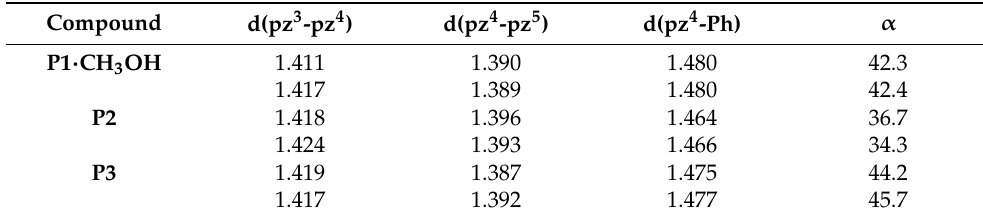
Table 4. Comparison of representative distances d (Å) and torsion angles between the pyrazole and the phenyl ring α ( ◦